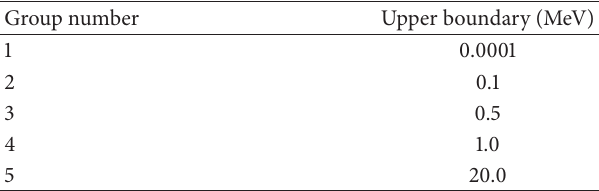
Table 5: BRR energy spectrum boundaries